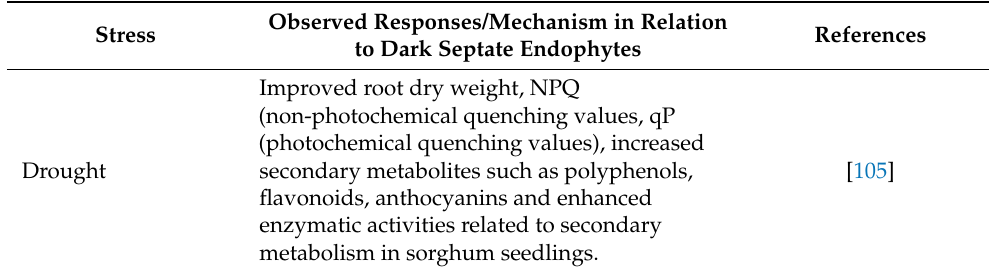
Table 2. Various abiotic stresses, observed responses and potential mechanisms involved in relation to Dark Septate Endophytes (DSE) association with the host plant